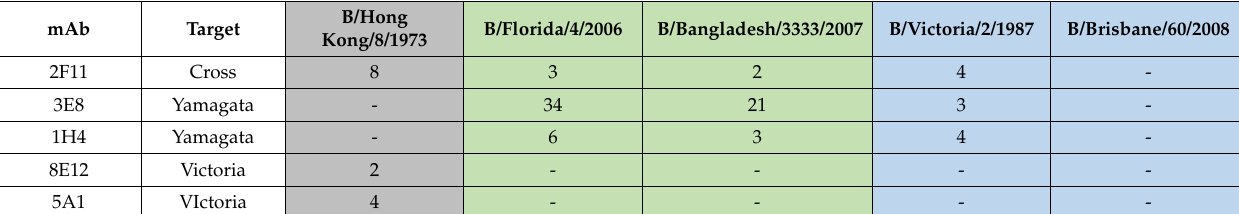
Table 3. IC 50 values in ng/mL for the neutralisation of 6 strains of influenza B HA-PV by mAbs. Pre-lineage strain, Yamagata and Victoria lineages highlighted in grey, green and blue, respectively. With the exception of B/Brisbane/60/2008, the cross lineage mAb 2F11 acts as expected, neutralising all influenza B PV. Yamagata specific mAbs neutralise PV bearing HAs from Yamagata lineage strains, while Victoria-specific mAbs neutralise PV bearing HAs from Victoria lineage strains with the exception of B/Brisbane/60/2008. The pre-lineage spli t strain B/Hong Kong/8/1973 is neutralised in a Victoria-like manner by 2F11 and Victoria lineage-specific mAbs 8E12 and 5A1.